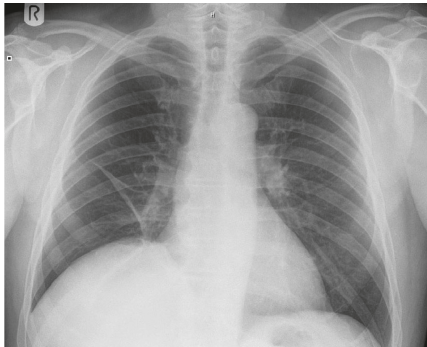
Figure 1: Preoperative chest radiograph in a 64-year-old man with right-sided stenosis at C3/4 and C4/5 demonstrating an elevated right hemidiaphragm.